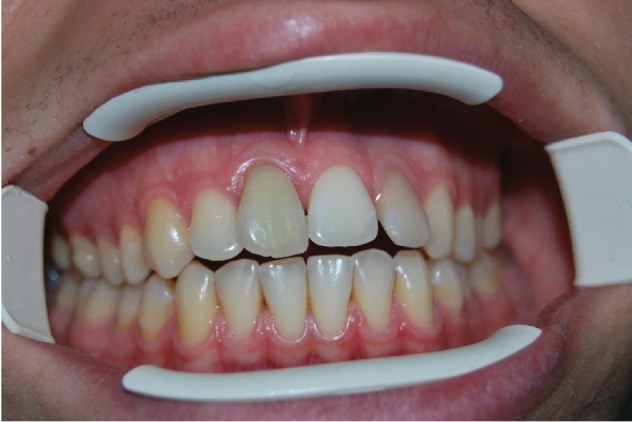
6-year follow-up.